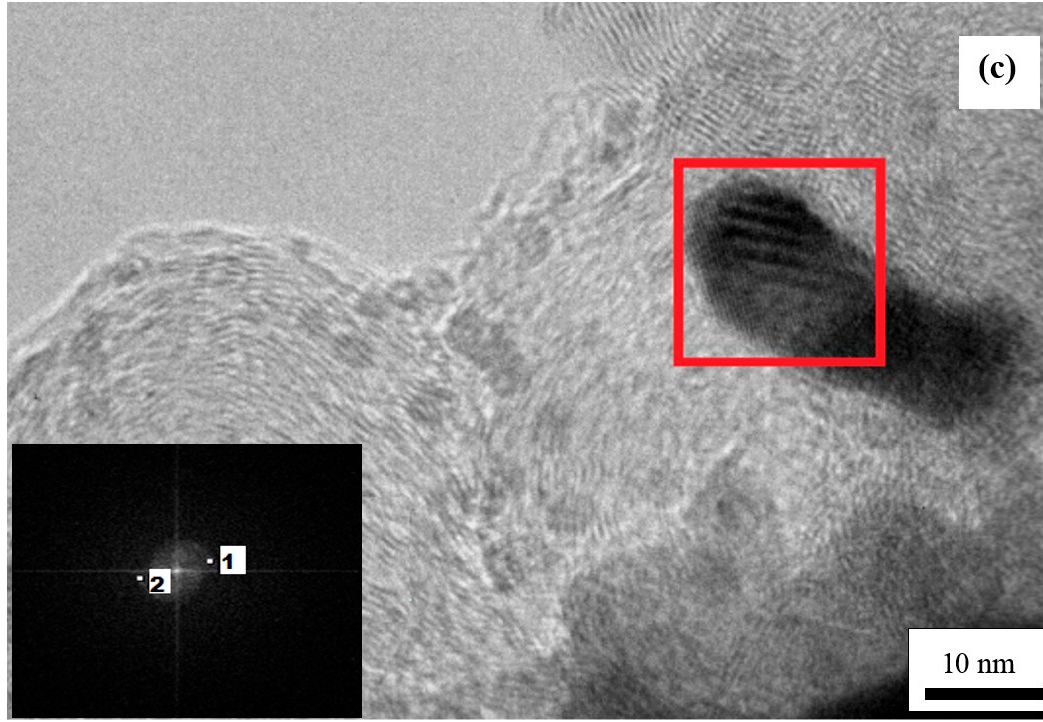
Figure 4. High Resolution Transmission Electron Microscopy (HRTEM) images of the: ( a ) Cu/C; ( b ) Pt(Cu)/C; ( c ) Pt-Ru(Cu)/C electrocatalysts of Figure 3. The insets depict the Fast Fourier Transform (FFT) analyses of the marked zones.